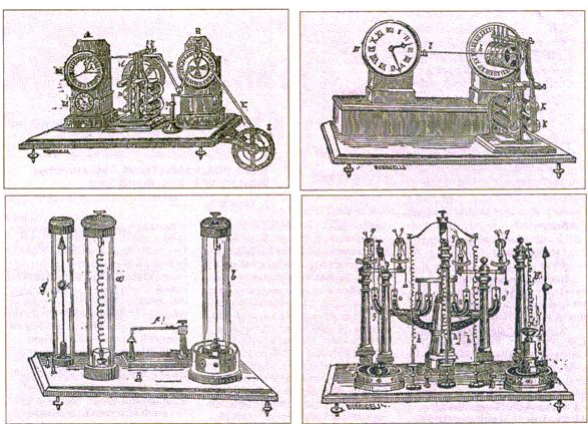
Figure 4. Examples of historical seismographs proposed by the Ot- toman Government (taken from the Ottoman Archive of the Turkish Republic).